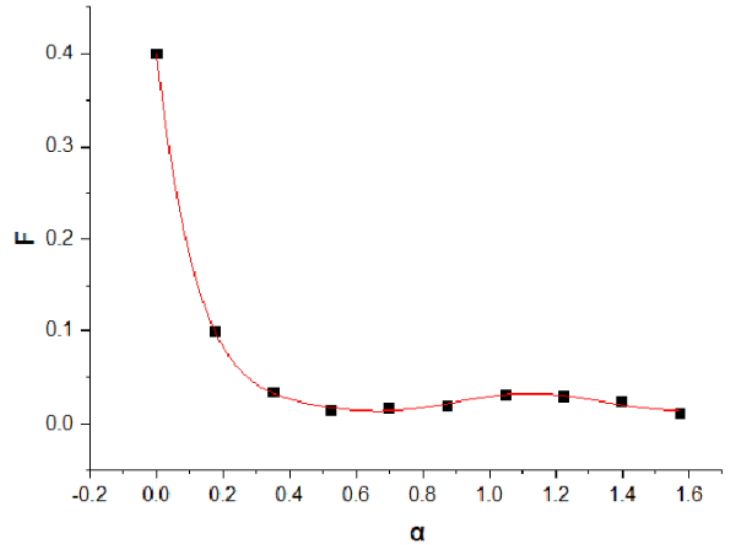
Figure 7. The fitting curve of F and α when h and R fixed.